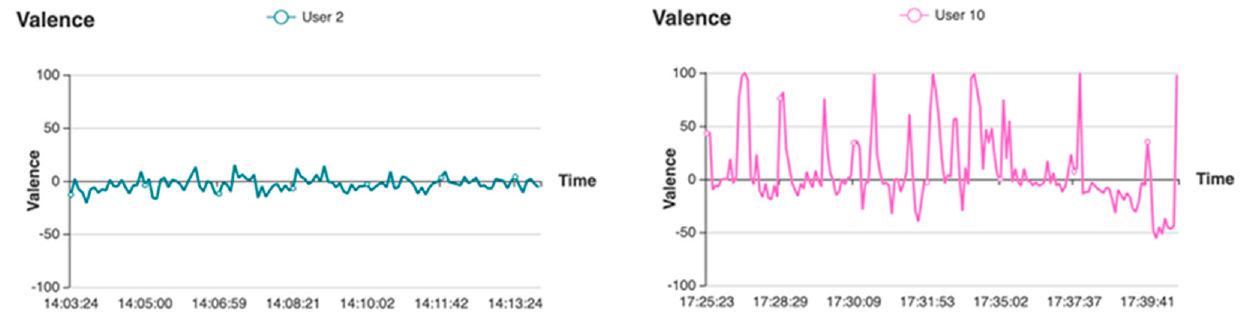
Figure 6. Collective emotions pie chart.